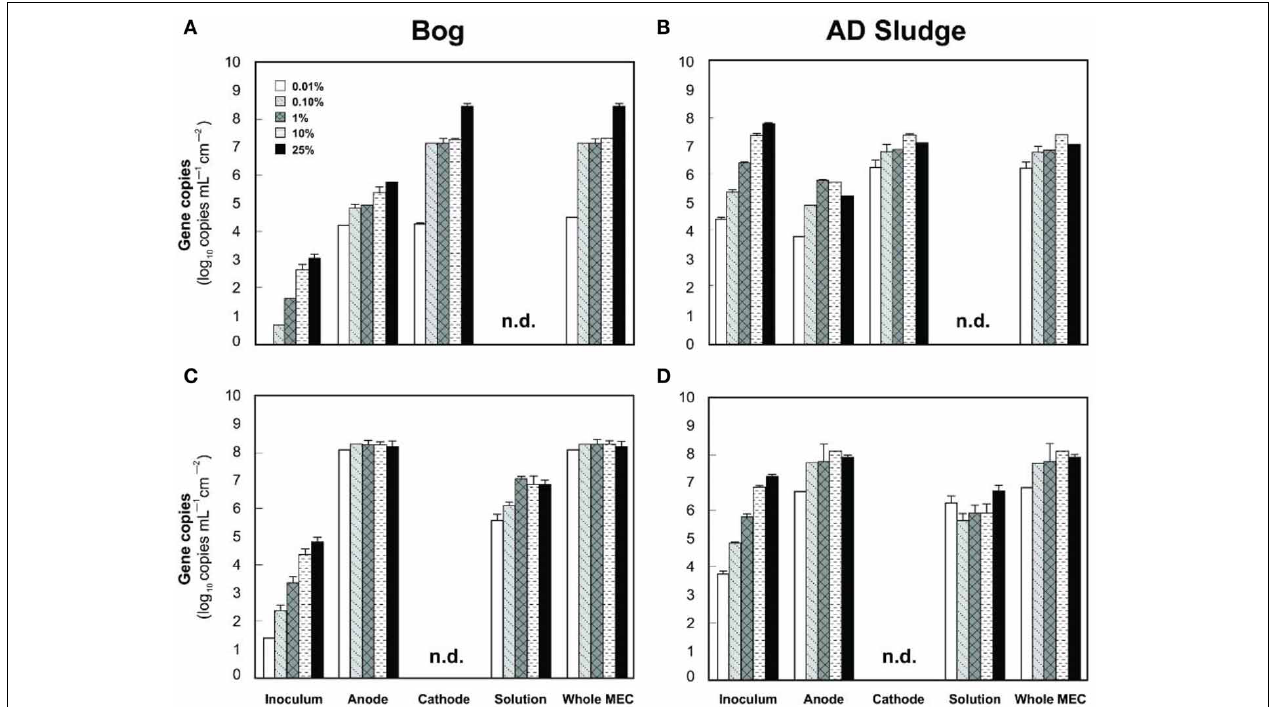
FIGURE 7 | Copy numbers mcrA (A,B) and Geobacteraceae (C,D) detected on the anodes, cathodes or solutions of bog (A,C) and AD sludge (B,D) inoculated MECs after 6 fed batch cycles. An absence of bars